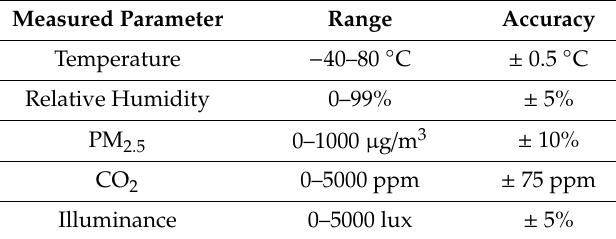
Table 6. The measured range and accuracy of IBEM